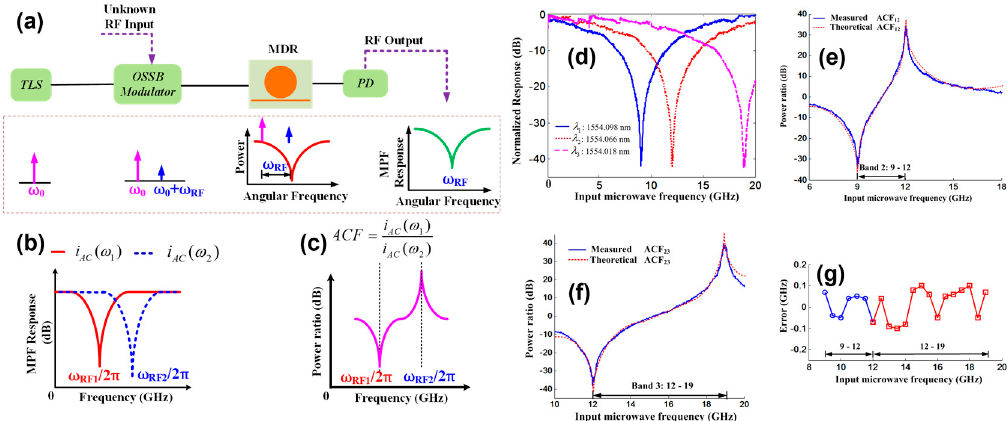
Figure 12. ( a ) Schematic diagram for microwave frequency measurement reported in [102]. ( b ) and ( c ) Calculated microwave photonic filter (MPF) responses and amplitude comparison function (ACF), respectively. ( d ) Measured MPF responses for three different wavelengths of λ 1 , λ 2 , λ 3 ( e ) Theoretical and measured ACF 12 when the system is operating at λ 1 and λ 2 , respectively. ( f ) Theoretical and measured ACF 12 when the system is operating at λ 2 and λ 3 , respectively. ( g ) Measurement range and error for the three wavelengths of λ 1 , λ 2 , λ 3 . Courtesy of Jianji Dong